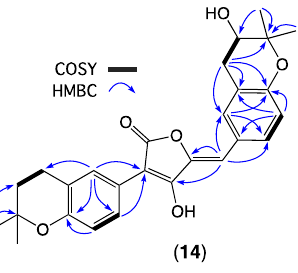
Figure 11. Selected 2D NMR (methanol- d 4 ) correlations for 14 . Table 4. 1D NMR (methanol- d 4 ) data for aspulvinone Y ( 14 ).